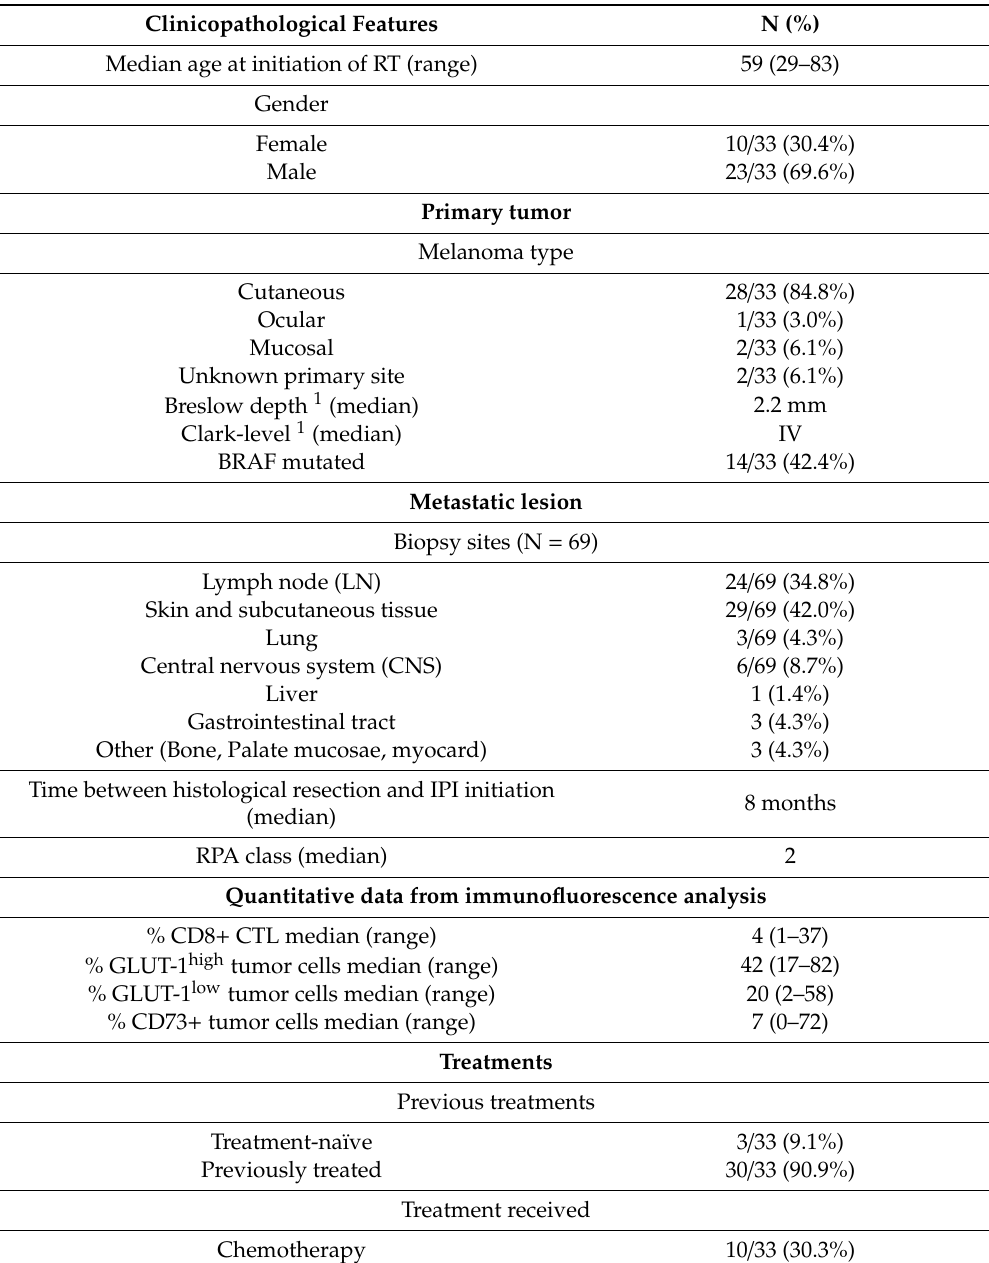
Table 1. Clinicopathological features of the investigated study